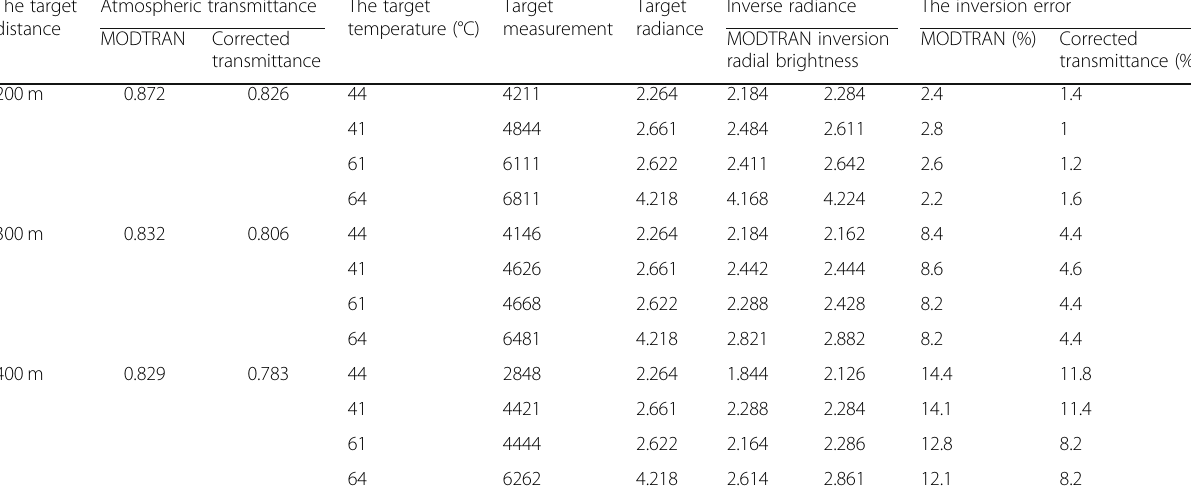
Table 8 Inversion results of atmospheric transmittance after modification when IT = 1 ms The target Atmospheric distance